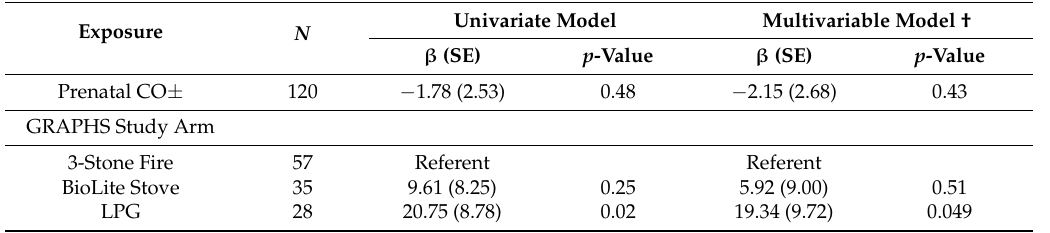
Table 2. Association between prenatal carbon monoxide (CO) exposure and GRAPHS study arm, considered independently, on cord blood mononuclear cell mitochondrial DNA copy number (mtDNAcn) percentage *: Linear